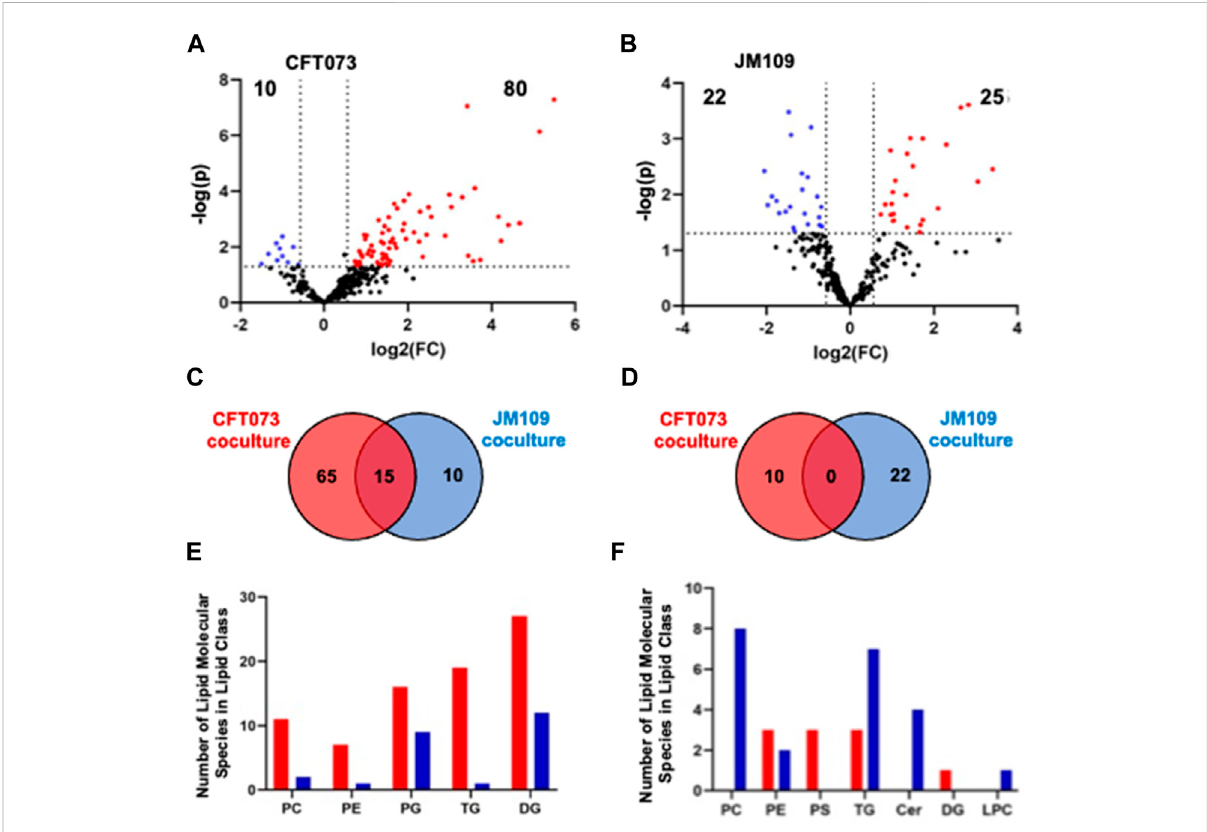
FIGURE 5 Untargeted lipidomics reveal altered lipid levels during bacteria coculture with endothelial cells and neutrophils. (A) Volcano plot comparing CFT073 coculture with CFT073 combined control. (B) Volcano plot of JM109 coculture compared to JM109 combined control. Statistical signi fi cancewasevaluatedby t -test( p- value < 0.05)andfoldchange(FC)thresholdat1.5.Thenumberofincreasedanddecreasedlipidsareshownin their respective quadrants. (C) Venn diagram representing increased lipid molecular species for comparisons between CFT073 coculture and JM109 coculture. (D) Decreased lipid species for comparisons betweenCFT073 and JM109 cocultures. (E) Increased lipid molecular species by lipid class from either CFT073 (red) and JM109 (blue) cocultures. (F) Decreased lipid molecular species by lipid class from either CFT073 or JM109